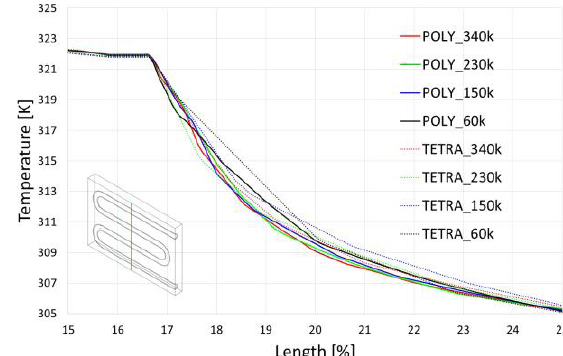
Fig. 11. Temperature along the segment of the centerline of the heat exchanger The temperature profile obtained with all POLY meshes is similar but the results for TETRA mesh of